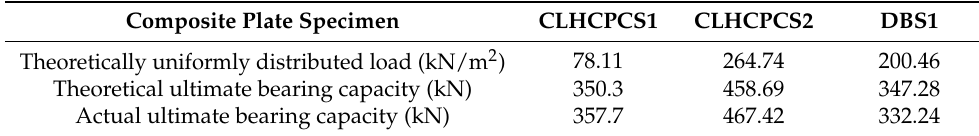
Figure 25. The cast-in-place layer model of a composite slab. Figure 26. The steel grid model of a composite slab. Concrete cracking and crushing can be well achieved in solid 65. After all geometric models are established, the corresponding material properties are added to each part. In this simulation, the reinforcement unit model selects link8 unit in the link unit, and the concrete unit is the solid 65 unit. 4.3. Finite Element Model Establishment of CLHCPCS (1) Basic assumptions of the model [52]: Considering that the composite slab is divided into a precast layer and a cast-in-place layer in the actual engineering practice, the concrete has differences due to the curing cy- cle. In this model, it is hypothesized that the precast layer and cast-in-place layer are in close contact with each other, and the reinforcement unit and concrete unit are bonded well and deformed consistently. (2) Unit selection and grid division The reinforcement unit shares a joint with the concrete unit. The mesh division de- termines the speed and accuracy of ANSYS finite element software processing [52,53]. The unit grid should be manageable in the division to prevent stress concentration. 50 mm was taken as the size for the grid division of solid65 and link8 units. (3) Load definition and boundary condition constraint definition